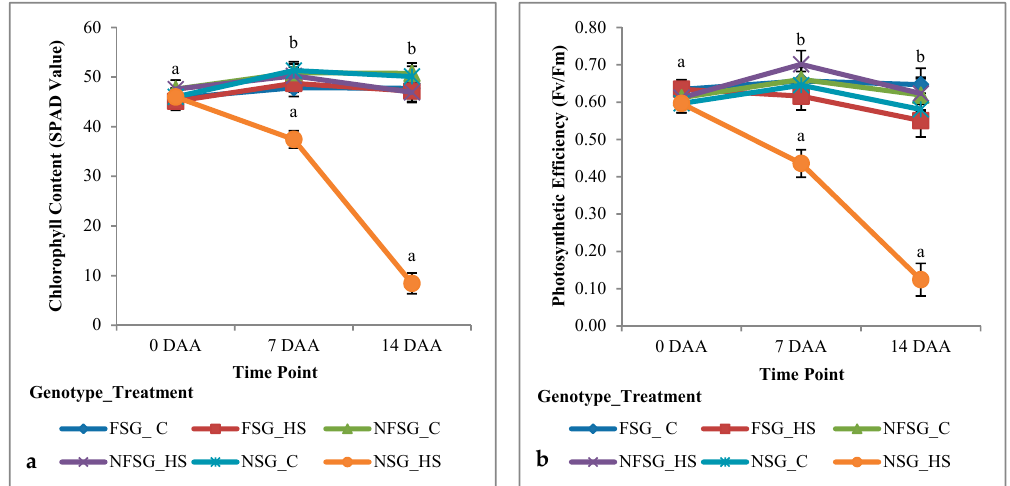
Figure 6. Chlorophyll content and photosynthetic e ffi ciency in the functional stay-green (FSG), non-functional stay-green (NFSG), and non-stay-green (NSG) genotypes at 0, 7, and 14 days after anthesis under control (C) and high temperature stress (HS). ( a ) Chlorophyll content; and ( b ) photosynthetic e ffi ciency. Line graphs represent the least square means. Error bars represent standard errors and di ff erent lowercase letters indicate the significant di ff erences among genotypes and treatments at p <